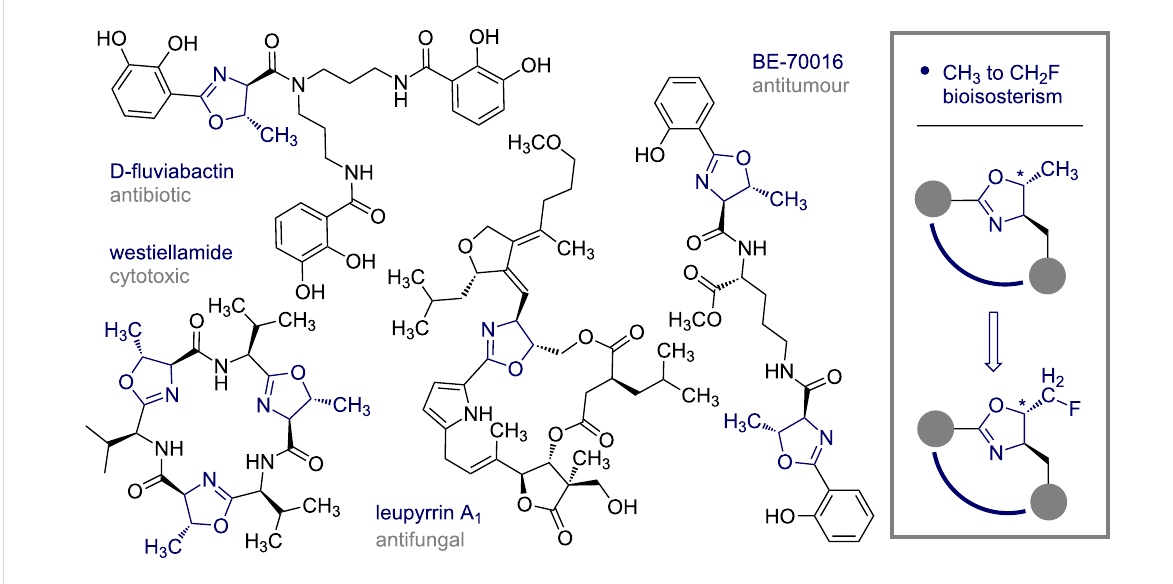
To contribute to the current catalysis ordnance for the prepara- tion of 2-oxazolines, and provide a direct route to 5-fluoro- methyl derivatives from simple unactivated alkenes, the fluoro- cyclisation of N -allylcarboxamides facilitated by the in situ gen- eration of p -TolIF 2 was envisaged [8-11]. Since hydrogen and hydroxy groups are often substituted by fluorine in molecular editing processes [12], this transformation would provide facile access to a bioisostere of the parent scaffold (Figure 1, right).